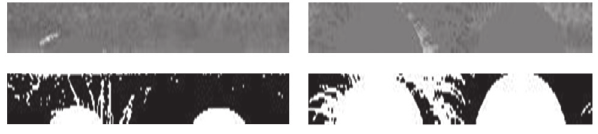
Figure 15. Samples of Normalized Iris Region and Its Noise. The top images are the normalized iris region. The bottom images are the noise (eyelids, eyelashes) in the normalized iris